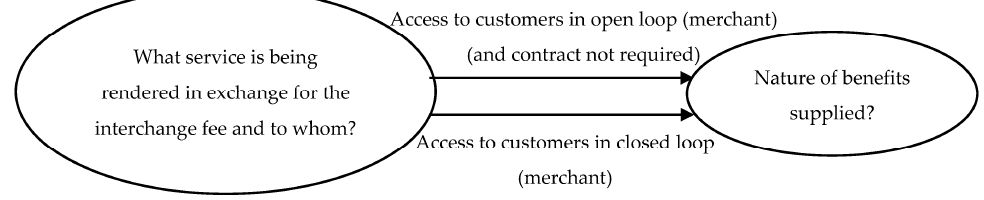
Figure 7. Identifying the merchant as card issuer’s customer. Cardholder as Customer